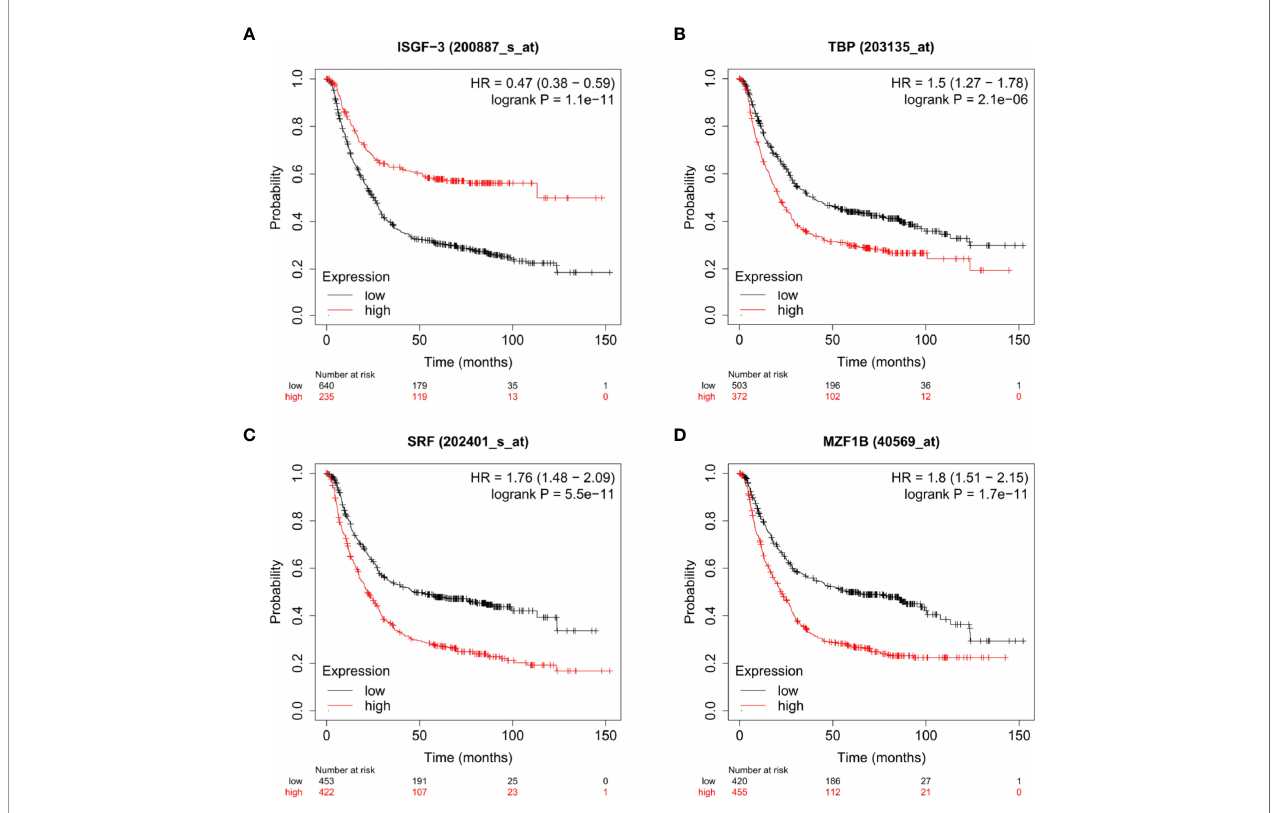
FIGURE 5 | The relationship between the expressions of ISGF-3 (A) , TBP (B) , SRF (C) , and MZF1 (D) and the prognosis of stomach cancer patients were shown by Kaplan – Meier survival